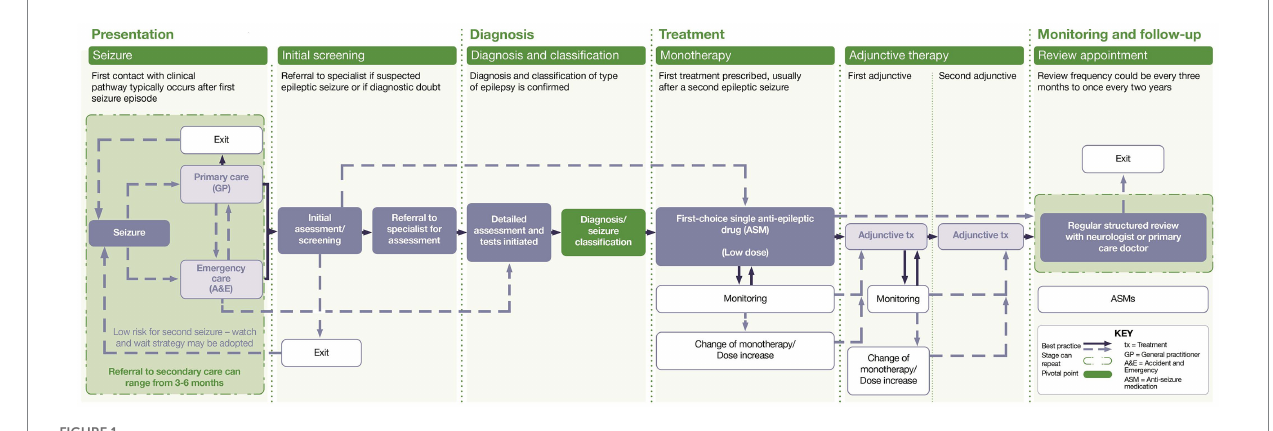
FIGURE 1 Clinical journey